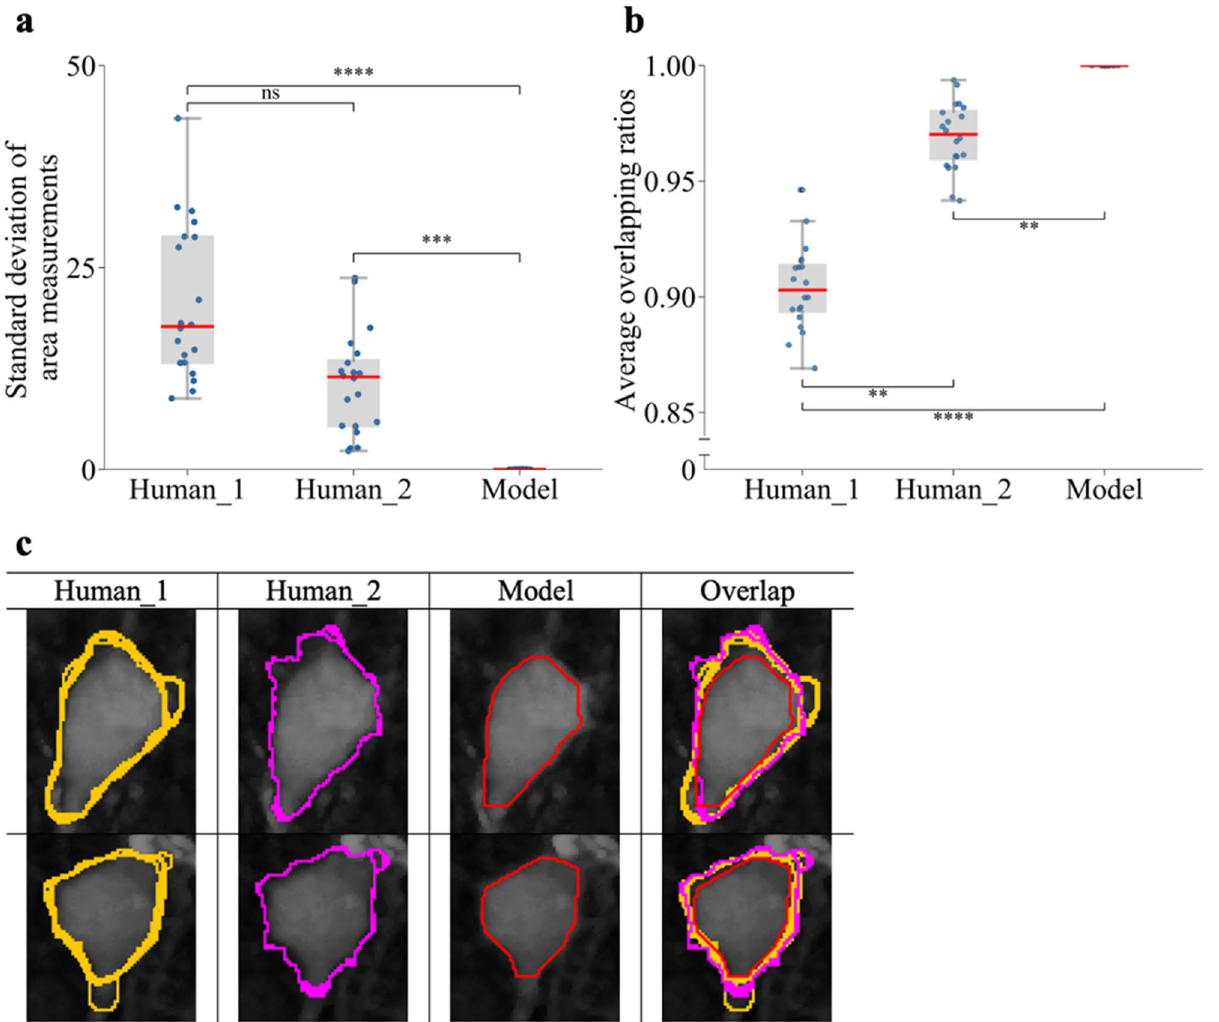
Figure 4. Somatic segmentation by the ANMAF framework lacked variability compared to human labelers. ( a ) The standard deviation of the somatic area measurements of each neuron obtained from two human annotators and the model ( p < 0.0001, Friedman test, significance between both Human_1 and Human_2 compared to the model, p < 0.0001 and = 0.004 respectively, Dunn’s post-hoc test, n = 20 neurons, five consecutive days). ( b ) Average overlapping ratios on contouring somatic regions (see “Methods” section) for the annotators and model ( p < 0.0001, Friedman test, significant differences between all groups, Dunn’s post-hoc test n = 20 neurons, five consecutive days). Y-axis is zoomed. ( c ) Two example neurons with five overlapping contours from two annotators and ANMAF. Note the identical overlap by ANMAF.